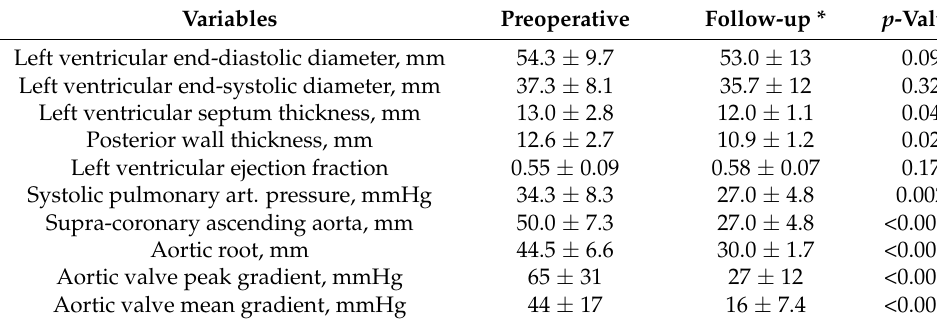
Table 2. Echocardiographic